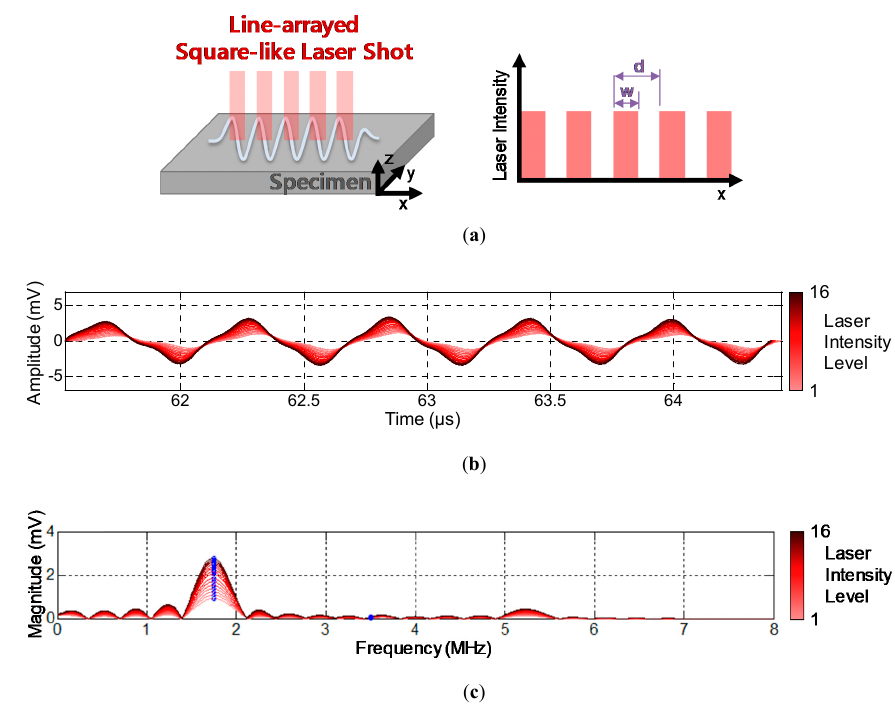
Figure 4. Figure 4. Waveforms of laser-generated SAW of 1.75 MHz and their frequency spectra with respect to the intensity of the line-arrayed square-like laser shot; ( a ) the intensity distribution of a line-arrayed square-like laser shot; ( b ) the waveforms of the SAW generated by the line-arrayed square-like laser shots; ( c ) the frequency spectra of the SAW generated by the line-arrayed square-like laser